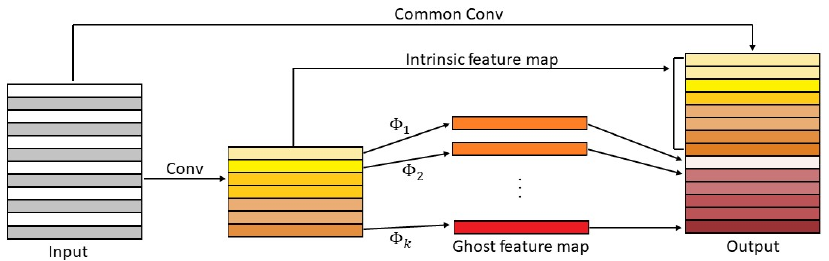
Figure 3. Representation of a GhostNet module